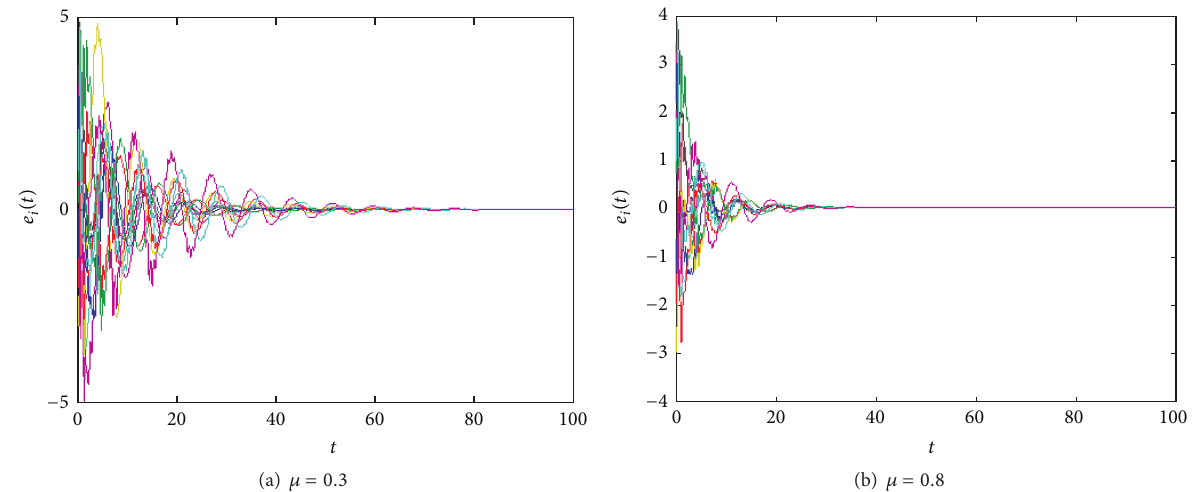
Figure 4: Synchronization errors for the super network with different value of 𝜇